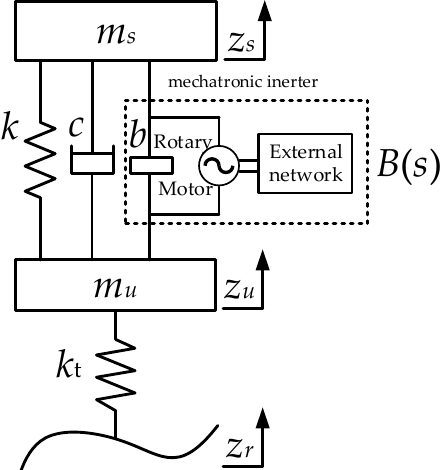
Figure 2. Based on a mature vehicle model, Table 2 illustrates the parameters for the model.